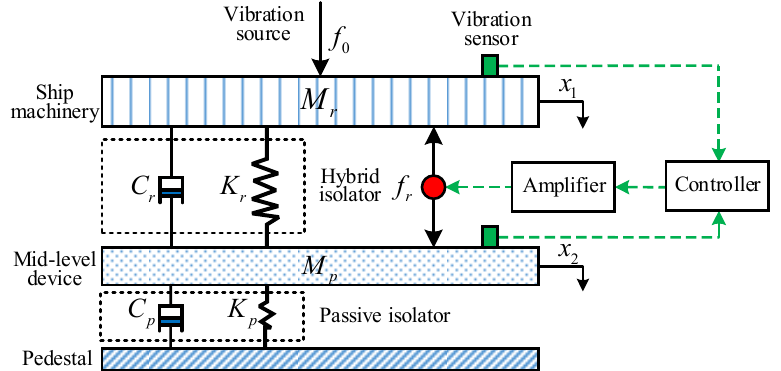
Figure 1. Mechanism of the two ‐ DOF active ‐ passive hybrid vibration isolation system.